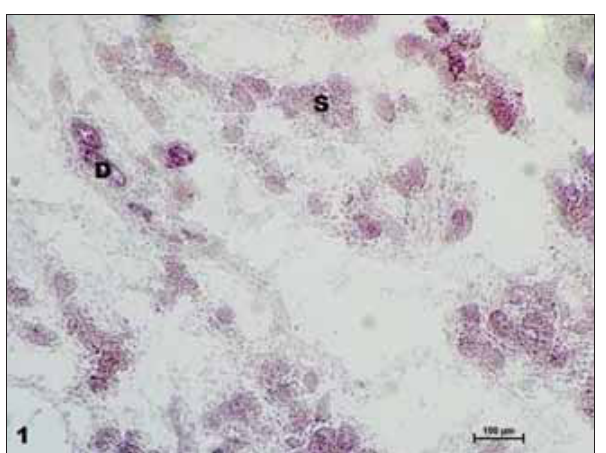
Figure-3: Photomicrograph of 37 cm curved crown-rump length (157 days) buffalo fetus showing moderate glucose- 6-phosphate dehydrogenase activity in serous acinar cells (S) of submandibular salivary gland. Interlobular ductular epithelium also showed similar type of activity (Nitro BT method × 100).